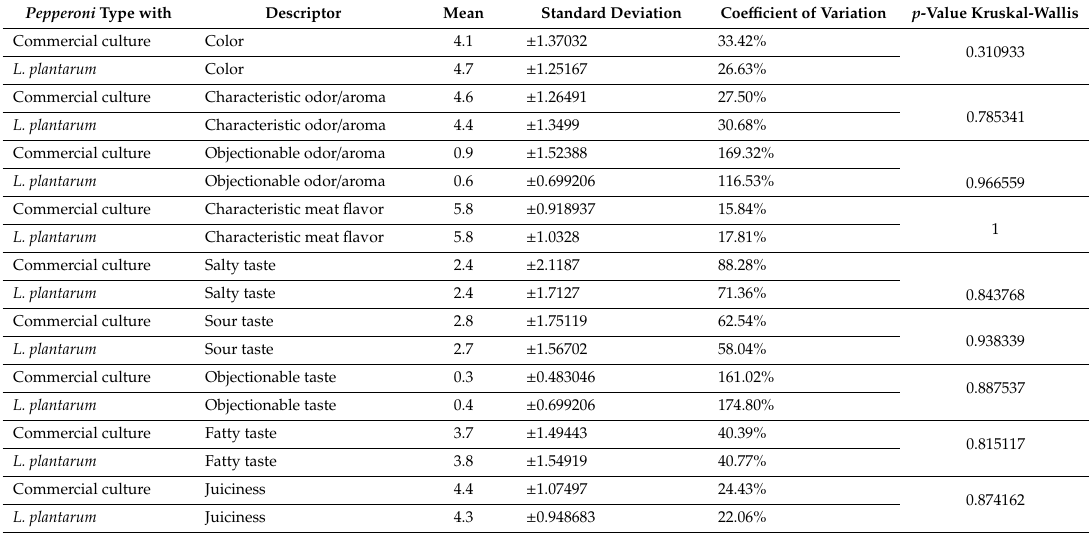
Table 7. Results of the Kruskal Wallis test for the sensory evaluation of pepperoni from the semi-trained panel of ten